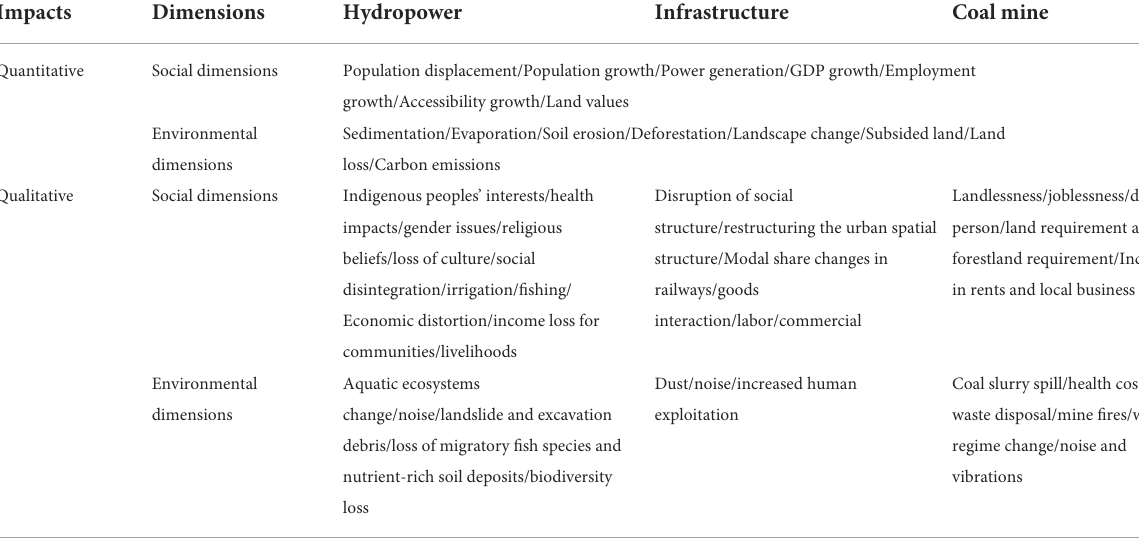
TABLE 3 Assessment indicators for Belt and Road Initiative (BRI) projects and just energy